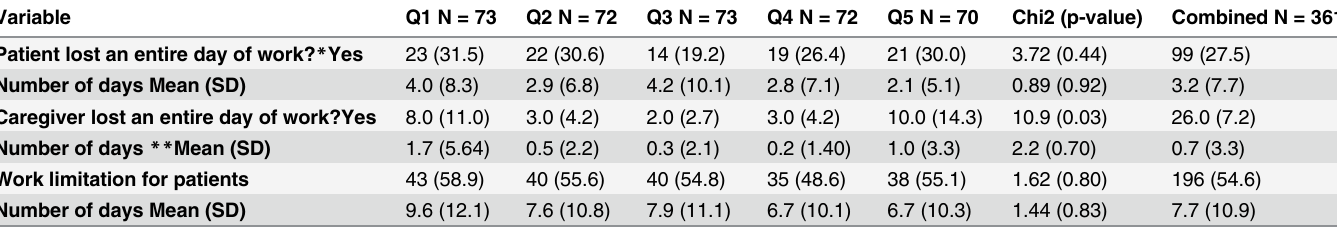
Table 5. Average monthly SES differences in the number of work days lost due to illness.